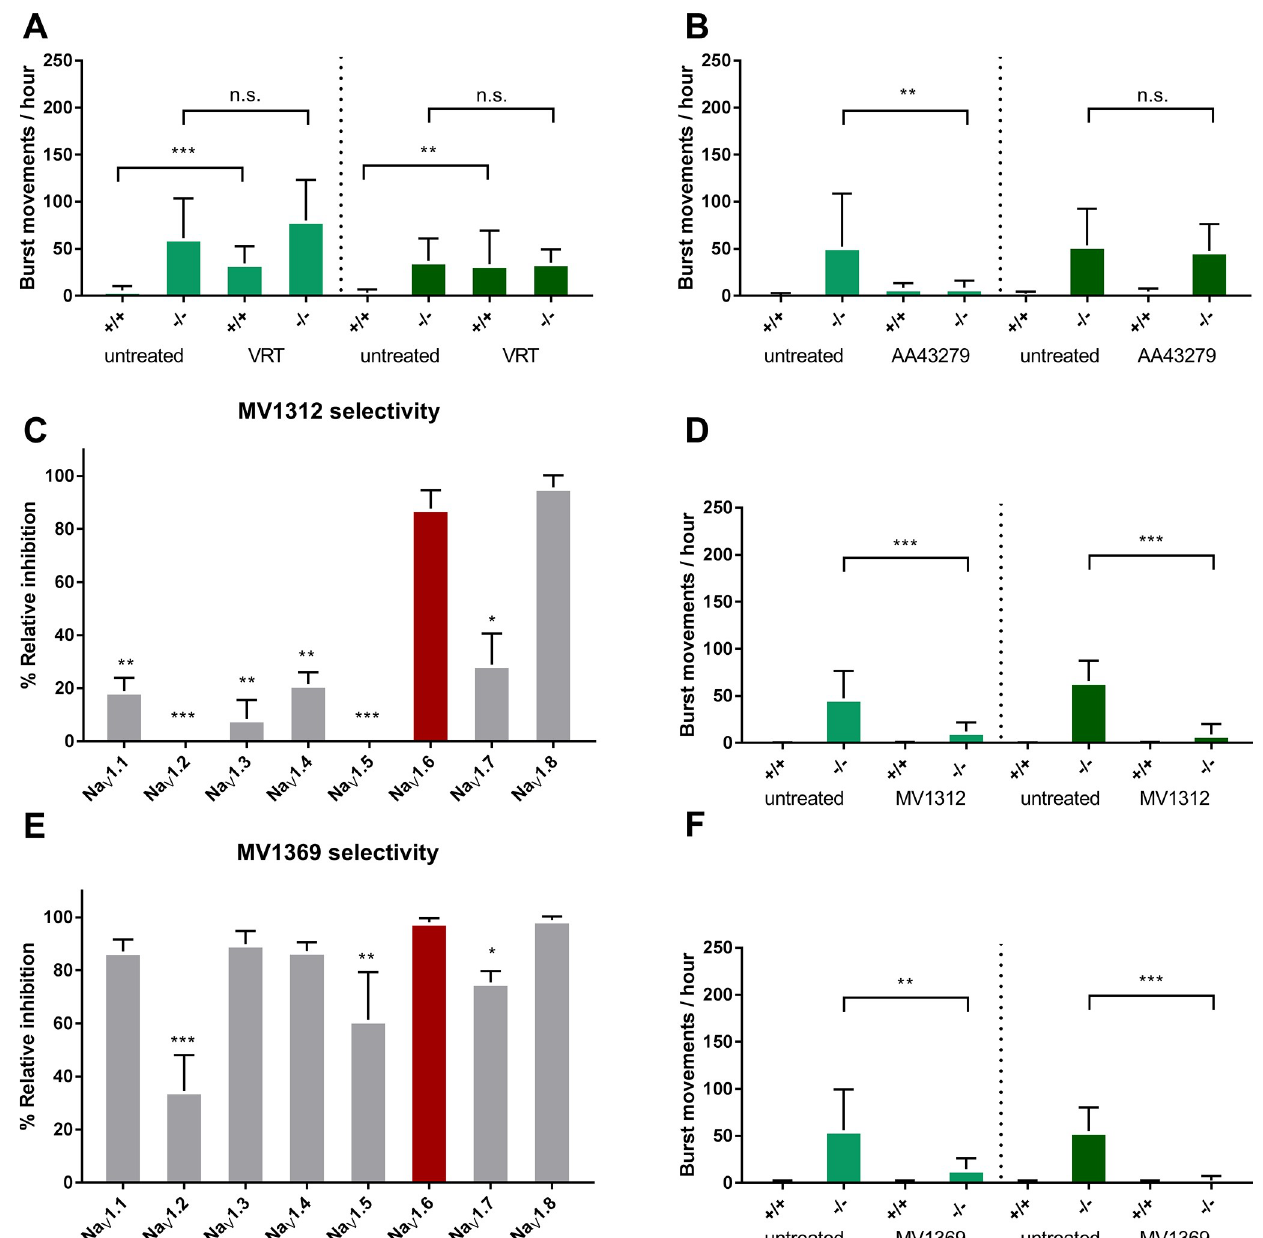
Fig 4. Characterization of novel compounds and their effect on Scn1Lab knockout burst movements by 60 minute (light green) or 18 hours (dark green) exposure A) 10 μ M Veratridine B) 5uM AA43279 C) MV1312 show blocking selectivity for Na V 1.6 over the other human ion channel subtypes but not Na V 1.8. D) 5 μ M MV1312 E) MV1369 shows blocking selectivity for Na V 1.6 over Na V 1.2, Na V 1.5 and Na V 1.7. F) 50 μ M MV1369. Dashed lines indicate a novel experimental plate with a seperate experimental group. Error bars = S . D ., (-/-) = Scn1Lab knockout , locomotor assays n = 12 per group , selectivity assays n = 3 per group , � < 0 . 05 �� < 0 . 005 ��� < 0 . 0005